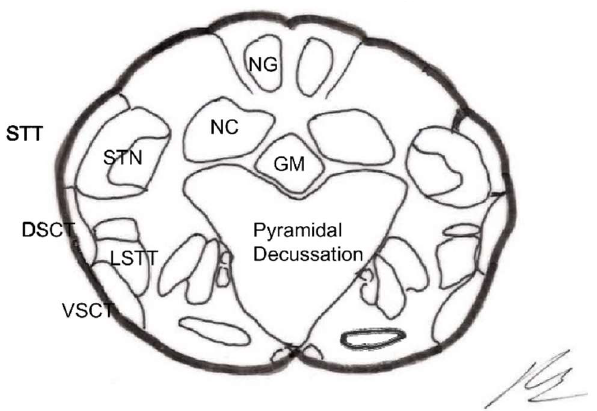
Figure 10. Section of the trigeminal spinal tract (TST) at the level approximately 11 mm below the obex (modified from [122]). GN—Gracile Nucleus. CN—Cuneate Nucleus. STrigT—Spinal Trigeminal Tract. STrigN—Spinal Trigeminal Nucleus. AECT—Anterior Spinocerebellar Tract. PECT—Posterior Spinocerebellar Tract. ATLS—Anterolateral System. CG—Central Gray.